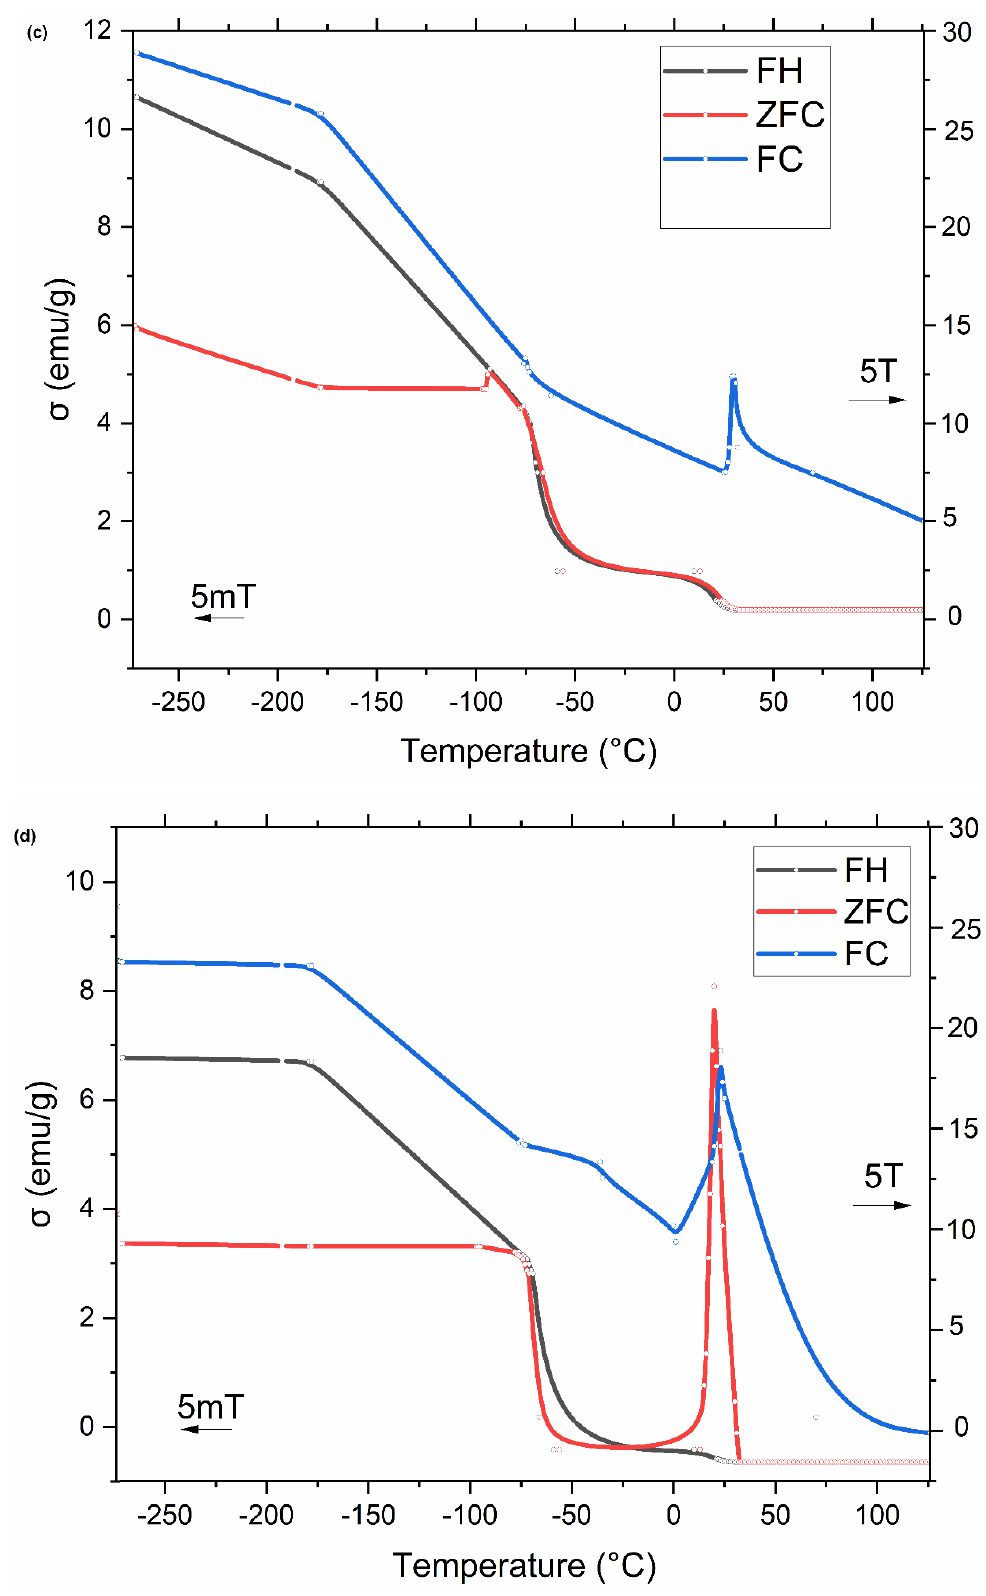
Figure 5. Magnetization vs. temperature curves for samples in magnetic fields of 5 mT and 5 T measured under ZFC (blue), FH (Black) and FC (red) where for Ni 50 − x Fe x Mn 30 Sn 20 − y In y 1 ≤ x ≤ 4; 2 ≤ y ≤ 8 alloy and ( a ) x = 1; ( b ) x = 2; ( c ) x = 3; ( d ) x = 4.